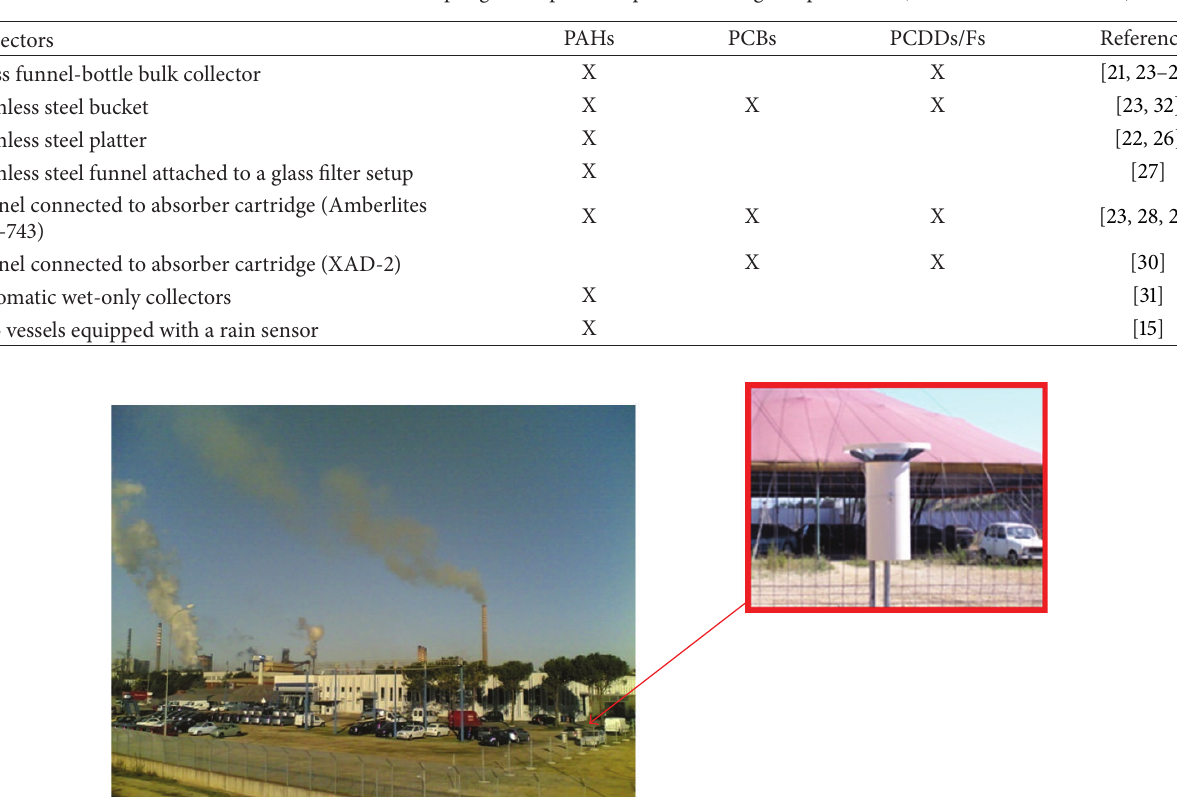
Table 2: List of different collectors used in sampling atmospheric deposition of organic pollutants (PAHs, PCBs, PCDDs/Fs).